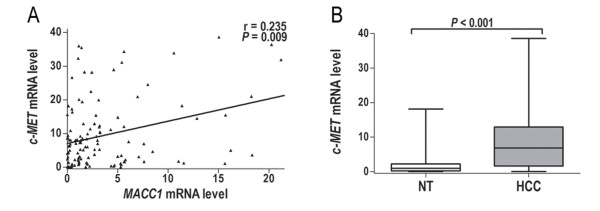
c-MET expression and correlation with MACC1 in 128 paired HCC specimens: A MACC1 levels from 128 HCC specimens were plotted against c-MET levels from the same patients. Linear regression analysis showed a significant positive correlation between MACC1 and c-MET (r = 0.567, P = 0.001). B Comparison of c-MET expression levels in 128 HCC specimens. The difference between HCC tissues and the adjacent non-cancerous tissues (NT) is significant (P < 0.001).